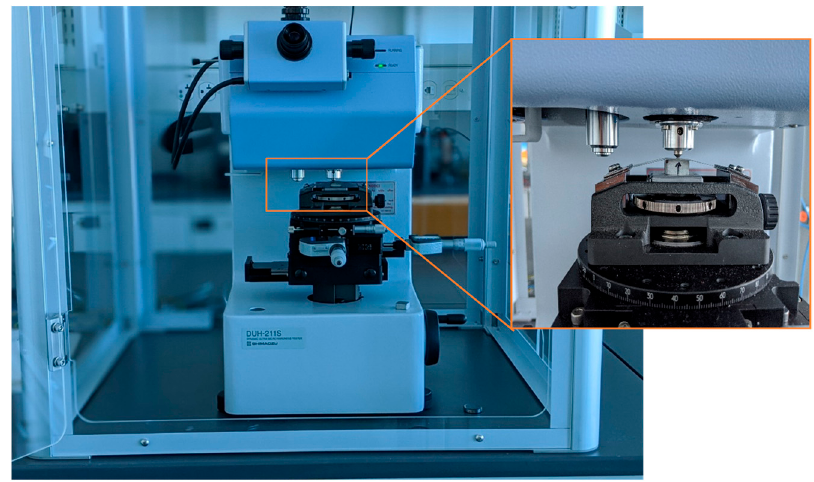
Figure 2. Microindentation test setup.